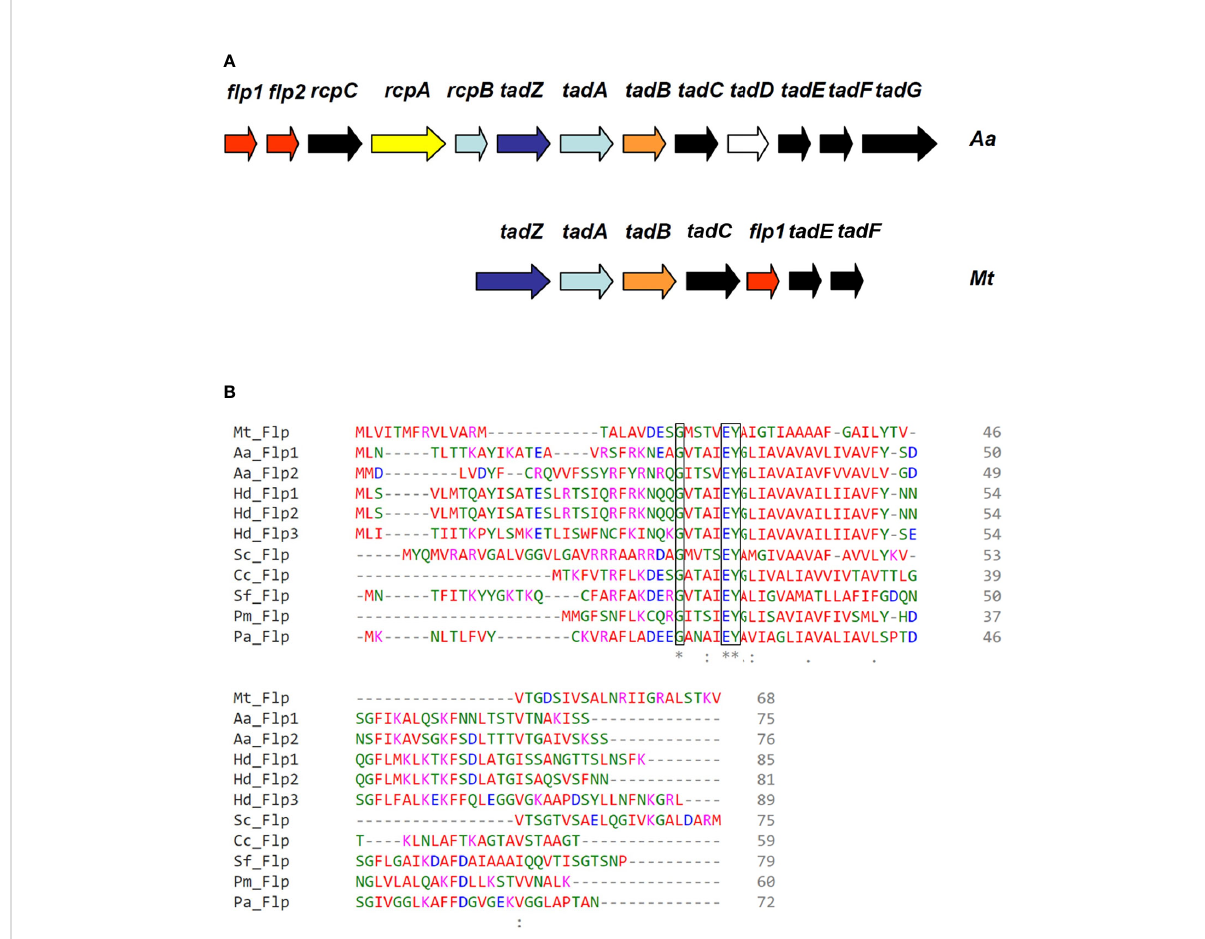
FIGURE 1 Identi fi cation of type IV pili genes of Mtb . (A) Correlation of tad / fl p gene cluster between Actinobacillus actinomycetemcomitans and Mtb . Illustrative of the tight adherence ( tad ) locus in A actinomycetemcomitans Aa and Mtb (Mt). Pilin encoding genes are indicated in red. (B) Multiple sequence alignment of Flp type IVB prepilins. Mtb H37Rv ORF Rv3656c encodes for a type IVB prepilin. The invariably conserved glycine just preceding the putative cleavage site of the leader peptide, and the glutamate-tyrosine pair at position fi ve of the mature pilin are boxed. The asterisk (*), colon (:), and dot (.) indicate identical, conserved, and semi-conserved amino acids among all aligned sequences. All predicted Flp pilins have an invariable glutamate-tyrosine pair of amino acids. Haemophilus ducreyi (Hd), Streptomyces coelicolor (Sc), Caulobacter crescentens (Cc), Shigella fl exneri (Sf), Pasteurella multocida (Pm), P. aeruginosa (Pa). Bacteria containing multiple Flp prepilins are indicated with numeric